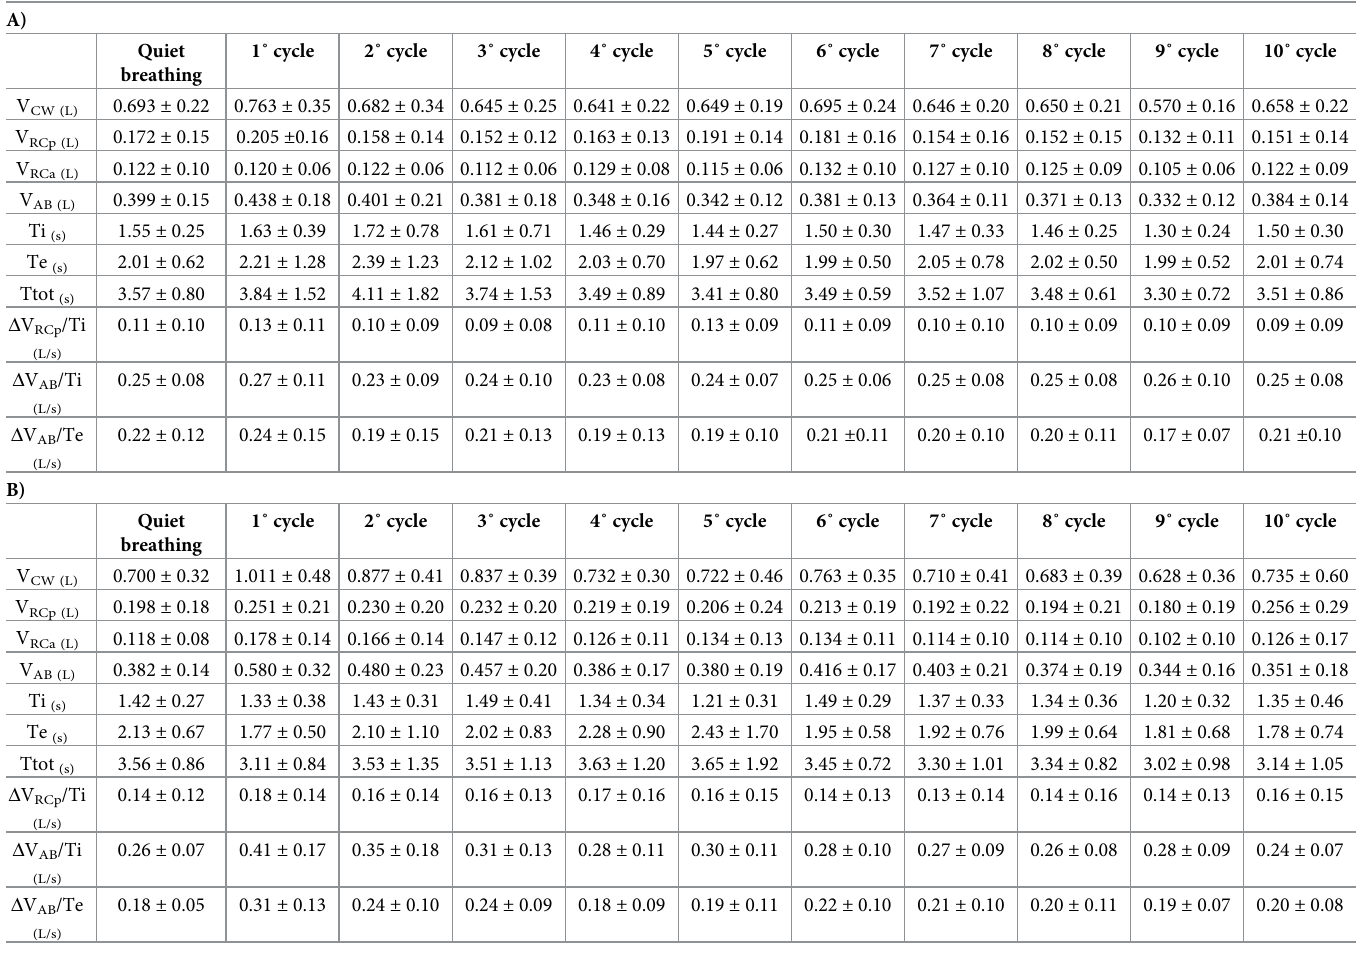
Table 3. Effects of deep expiration (A) and inspiratory contraction (B) from the residual volume on the chest wall volumes.